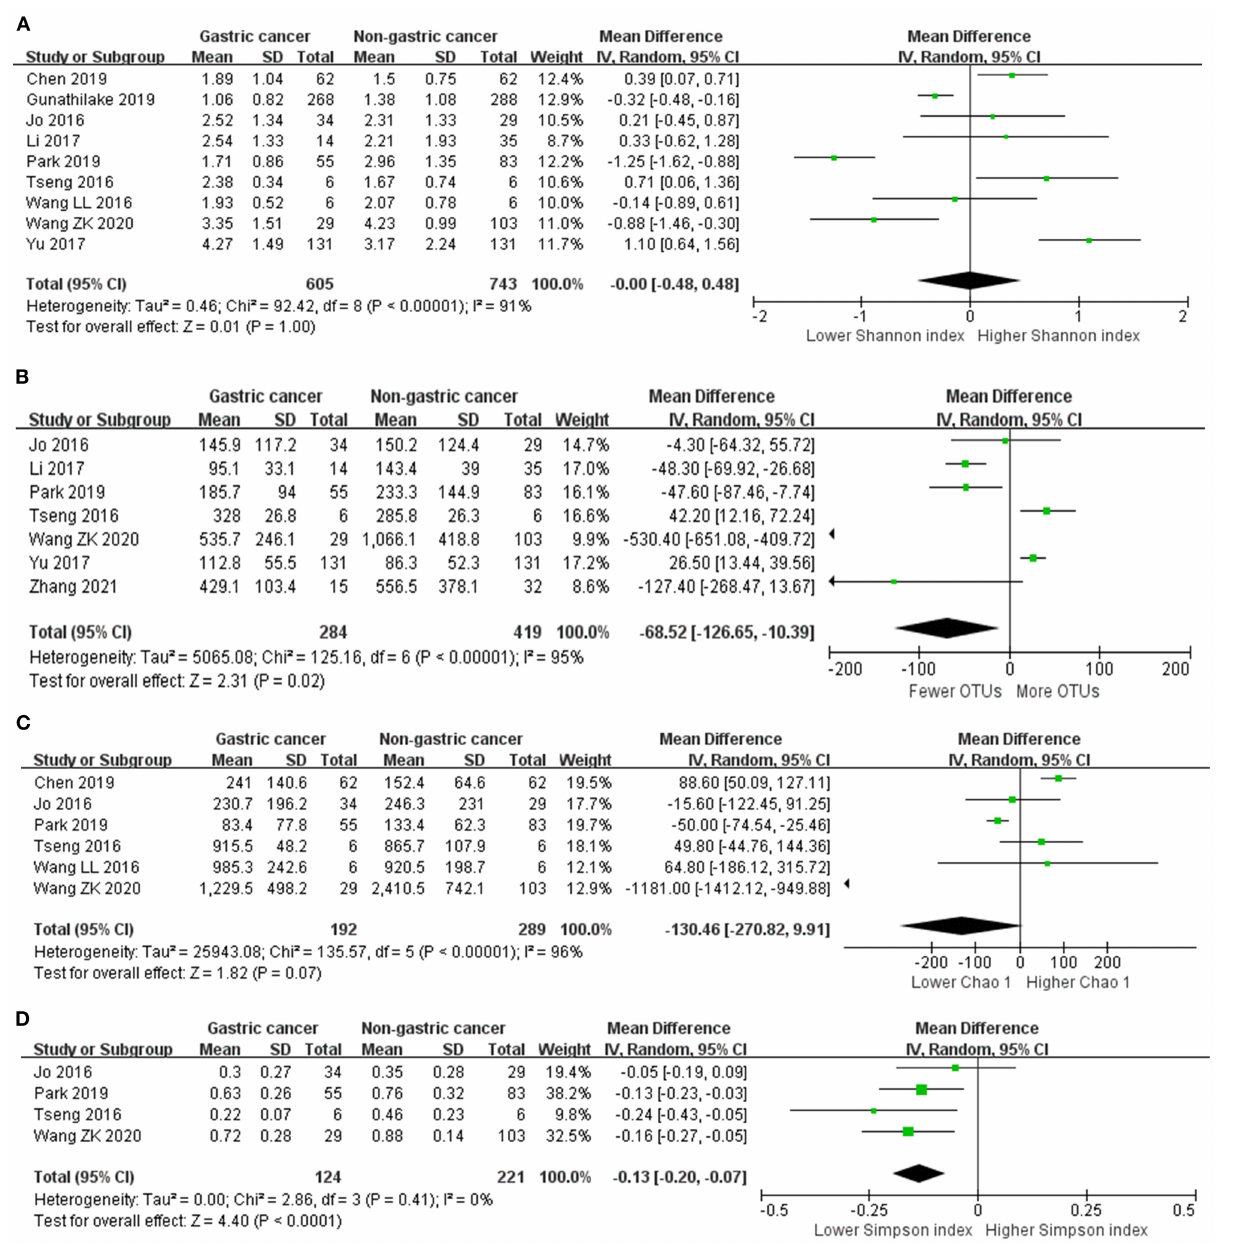
Sources of samples, sample size and H. pylori